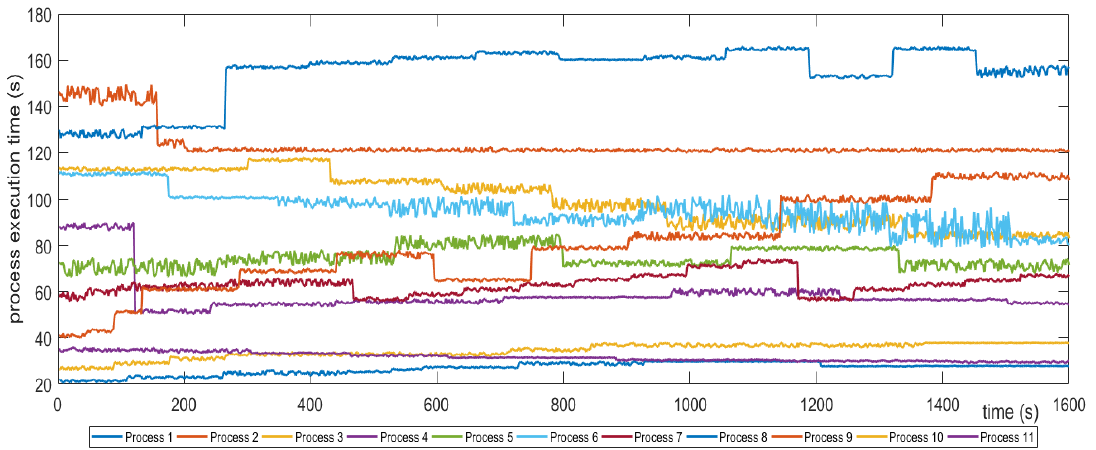
Figure 25. Total execution time per